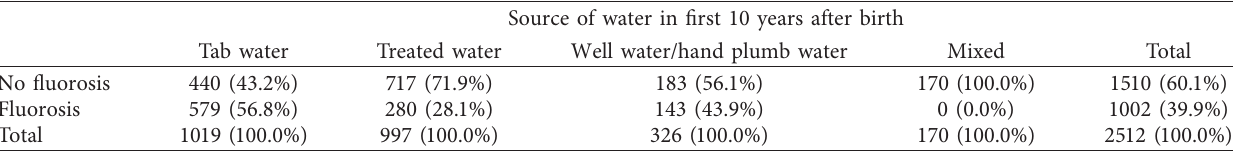
Table 4: Incidence of fluorosis grouped by source of water in first 10 years after birth.